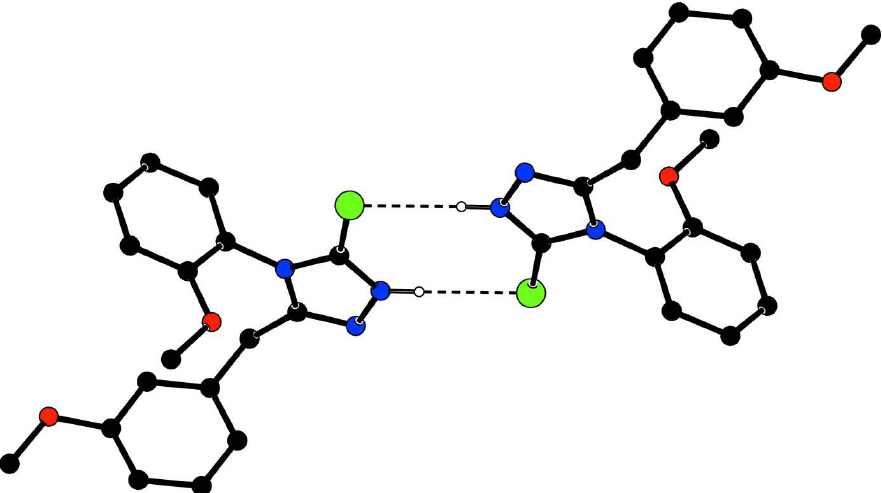
Figure 2 Part of the crystal structure of (I) showing hydrogen bonds as dashed